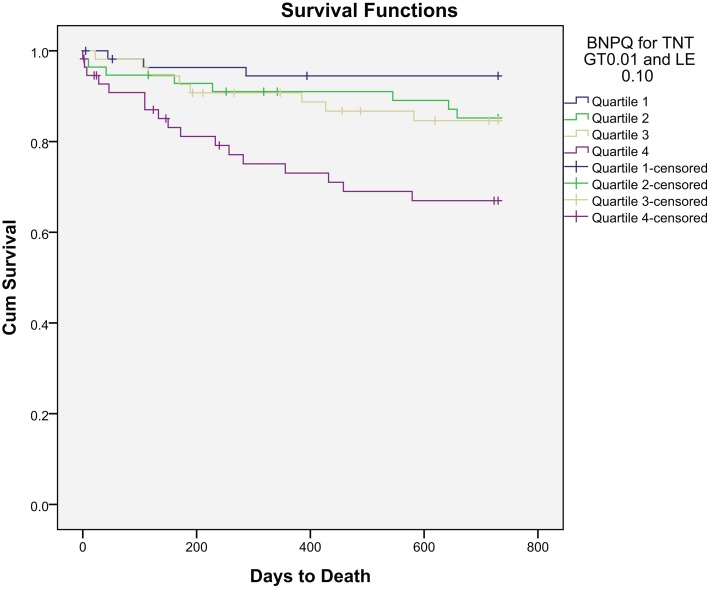
Kaplan–Meier plot of time to cardiac death within 2 years by BNP quartiles.